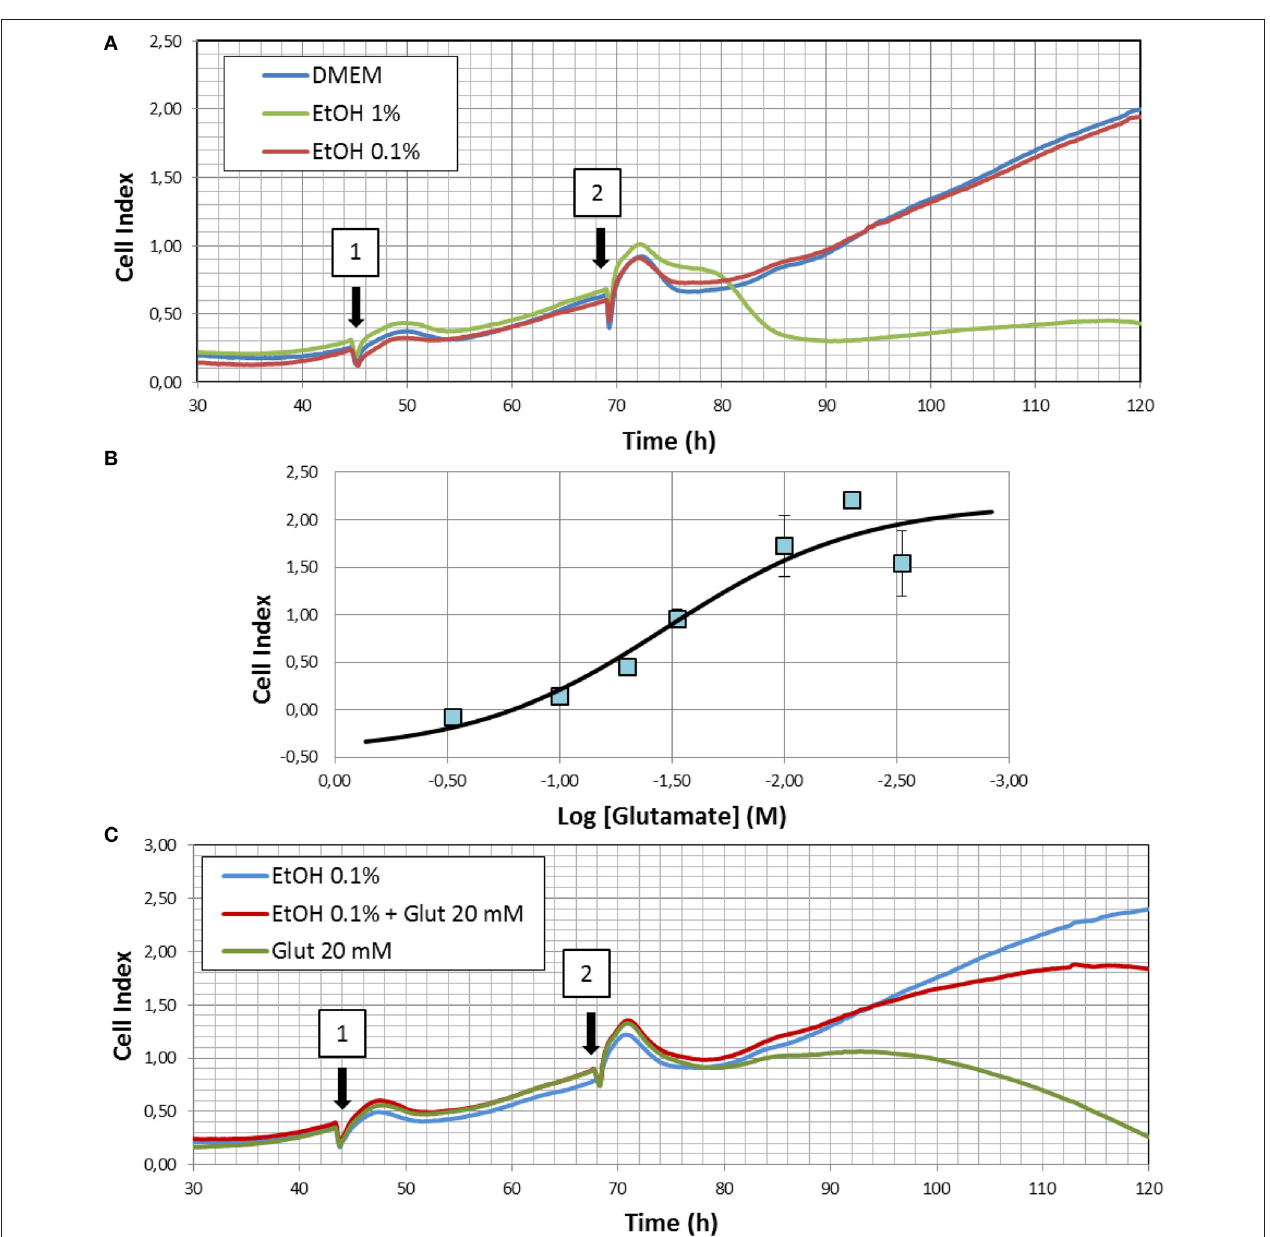
FIGURE 5 | (A) Representative experiment showing the effects of 0.1 and 1% ethanol (EtOH) on real time cell proliferation. Arrows indicate the time where media were replaced by either DMEM or EtOH 0.1% in 1 or DMEM, EtOH 0.1, or EtOH 1% in 2. (B) Dose-response curve for glutamate toxicity in HT22 cells. Results summarize data from three different experiments and are indicated as mean ± SEM. (C) Neuroprotective effects of 0.1% ethanol. Illustrated correspond to a representative experiment of glutamate excitotoxicity in the presence or absence of ethanol. Arrows indicate the time where cells were exposed to either DMEM, EtOH 0.1, or